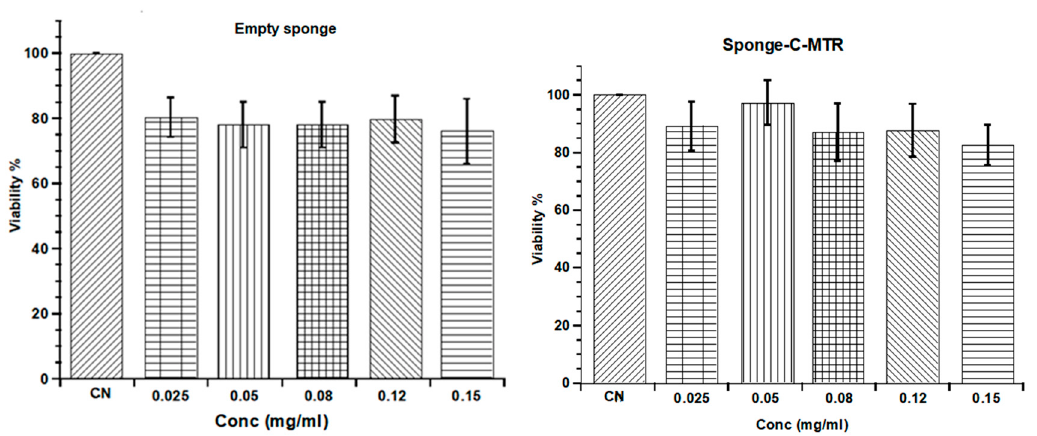
Figure 14. Cell viability of homo sapiens bone marrow stromal cells (HS5) cells after 24 h of treatment at different concentrations of the empty nanocomposite sponge or the Sponge-C-MTR compared to the cell viability of untreated cells (CN). Results were the means ± SE of three separate experiments.